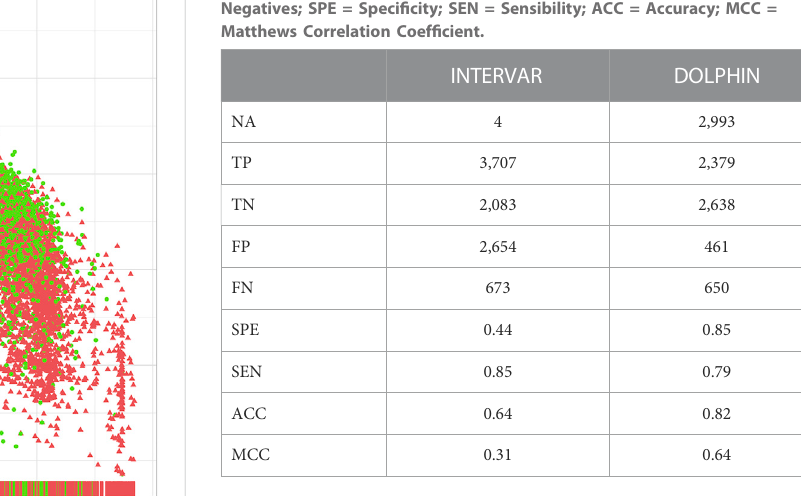
TABLE 1 PM1 classi fi cation of ClinVar variants localized in protein domains. TP = True Positives; TN = True Negatives; FP = False Positives; FN =